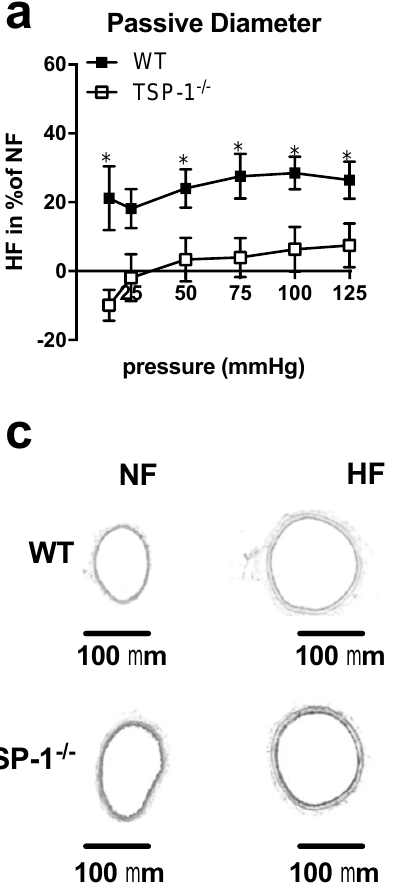
Figure 1 . Remodeling of TSP-1 − / − and WT mesenteric arteries after seven days of chronic increase in blood flow. Graphs show ( a ) the passive diameter of HF arteries in percent of NF arteries and ( b ) the histomorphometry analysis as media-to-lumen ratio. TSP-1 − / − ( n = 7) mesenteric arteries are represented in white and WT ( n = 5) in black. ( c ) shows representative images (×10 magnification, scale bar = 100 µm). All results are expressed in means ± sem. * p < 0.05, WT vs. TSP-1 − / − .